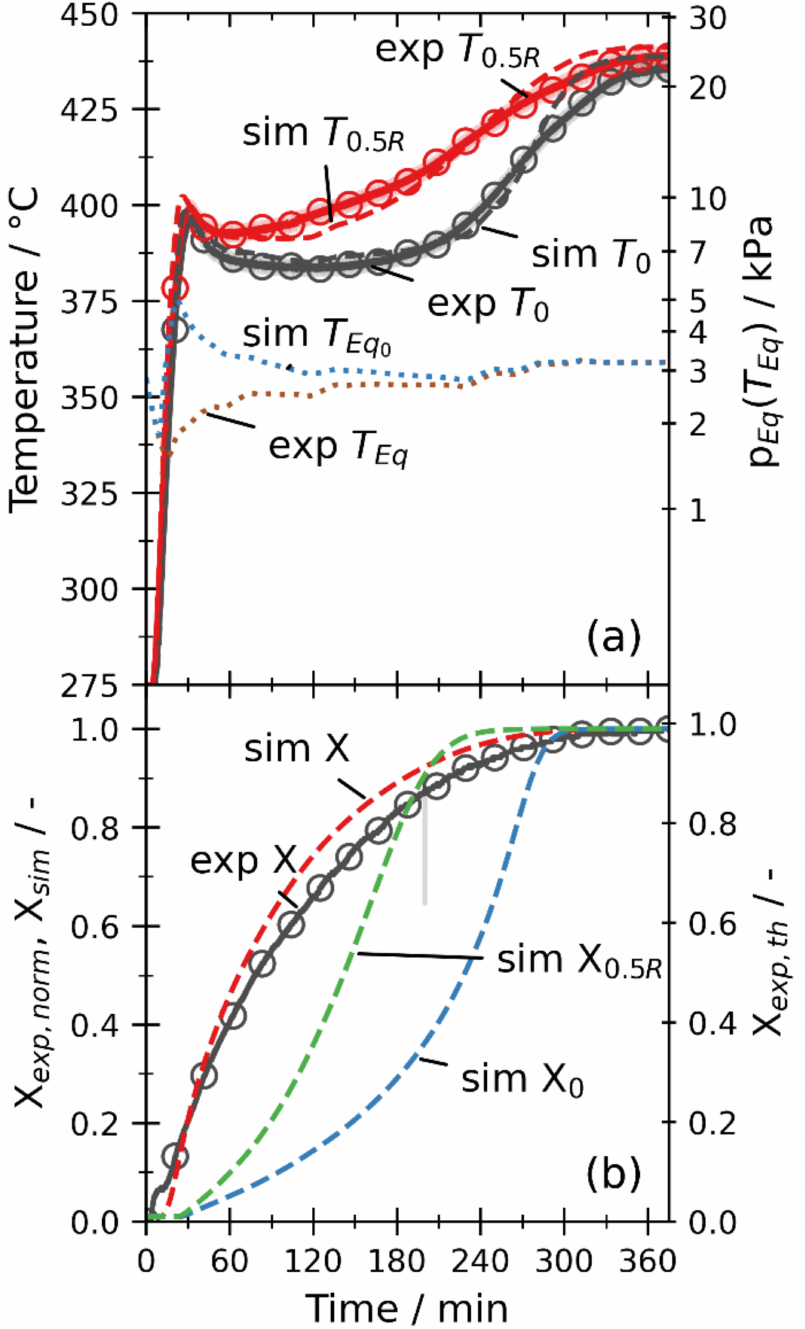
Figure 4. Experimental and numerical results of temperatures ( a ) and conversions ( b ) for experiment “E13” with an assumed particle diameter of 5 µ m for the simulation. The dehydration is triggered by a temperature rise with a steam pressure of about 2.8 kPa and heaters set to 450 ◦ C. MAEs are 3 K for T 0 and T 0.5R and 0.04 for the global conversion. The corresponding equilibrium pressure of the equilibrium temperatures (sim T Eq and exp T Eq ) is shown on the right pressure 0